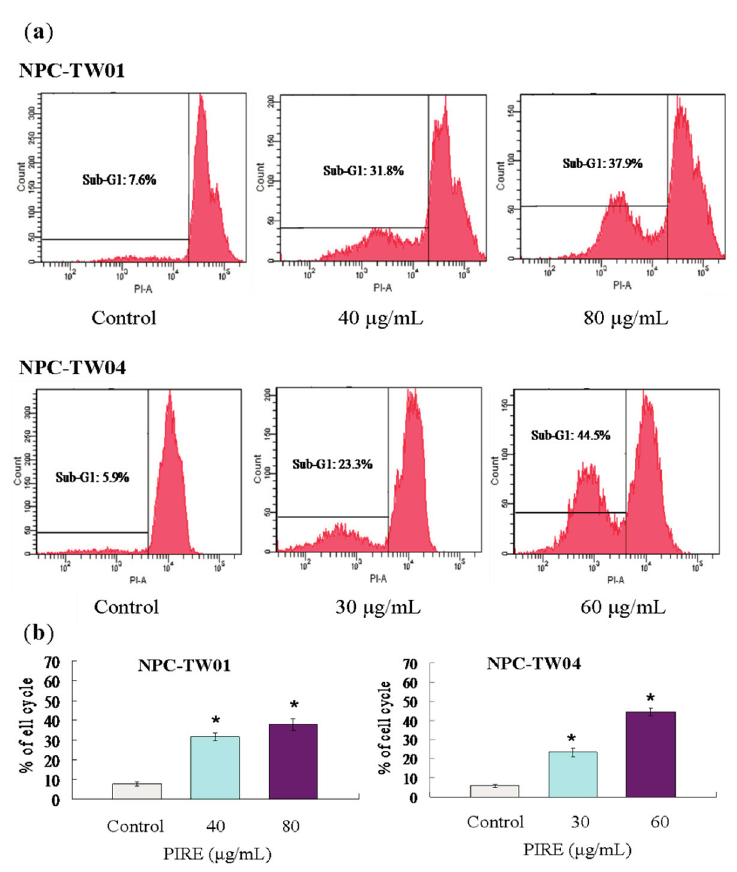
Figure 4. Flow cytometry analysis of NPC cells treated with PIRE. ( a ) Cells in 60 mm culture dishes were treated with varying concentrations of PIRE or 0.1% DMSO for 48